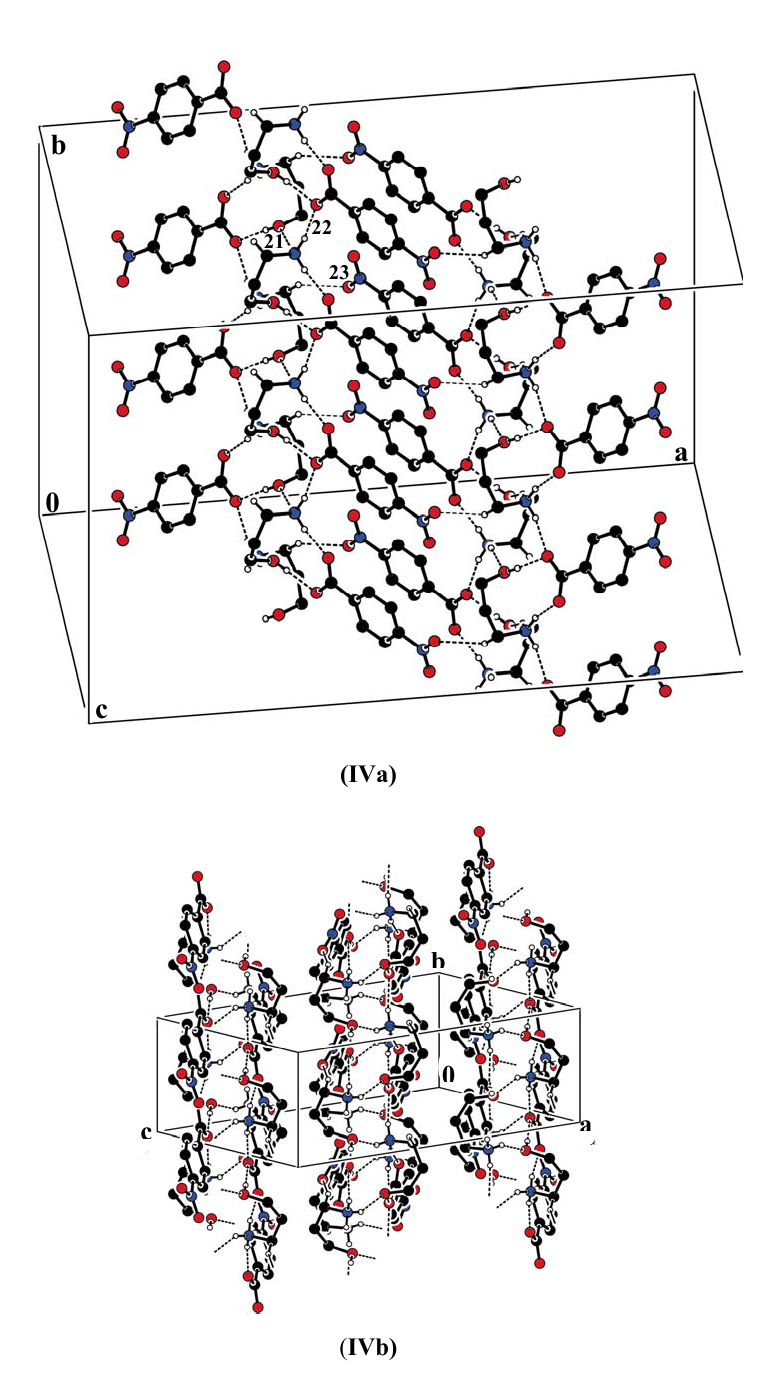
Fig. 5 ( IVa ) View of double H-bonded chain running along b direction. Building blocks form the infinite helix-like chains via N2 ... O5 (21) and N2 ... O2 (22) hydrogen bonds (dashed lines). These chains are joined by glide plane through the C10 ... O3 (23) hy- drogen bonds. ( IVb ) Fragment of molecular packing in IV. Non-functional hydrogen atoms are omitted for